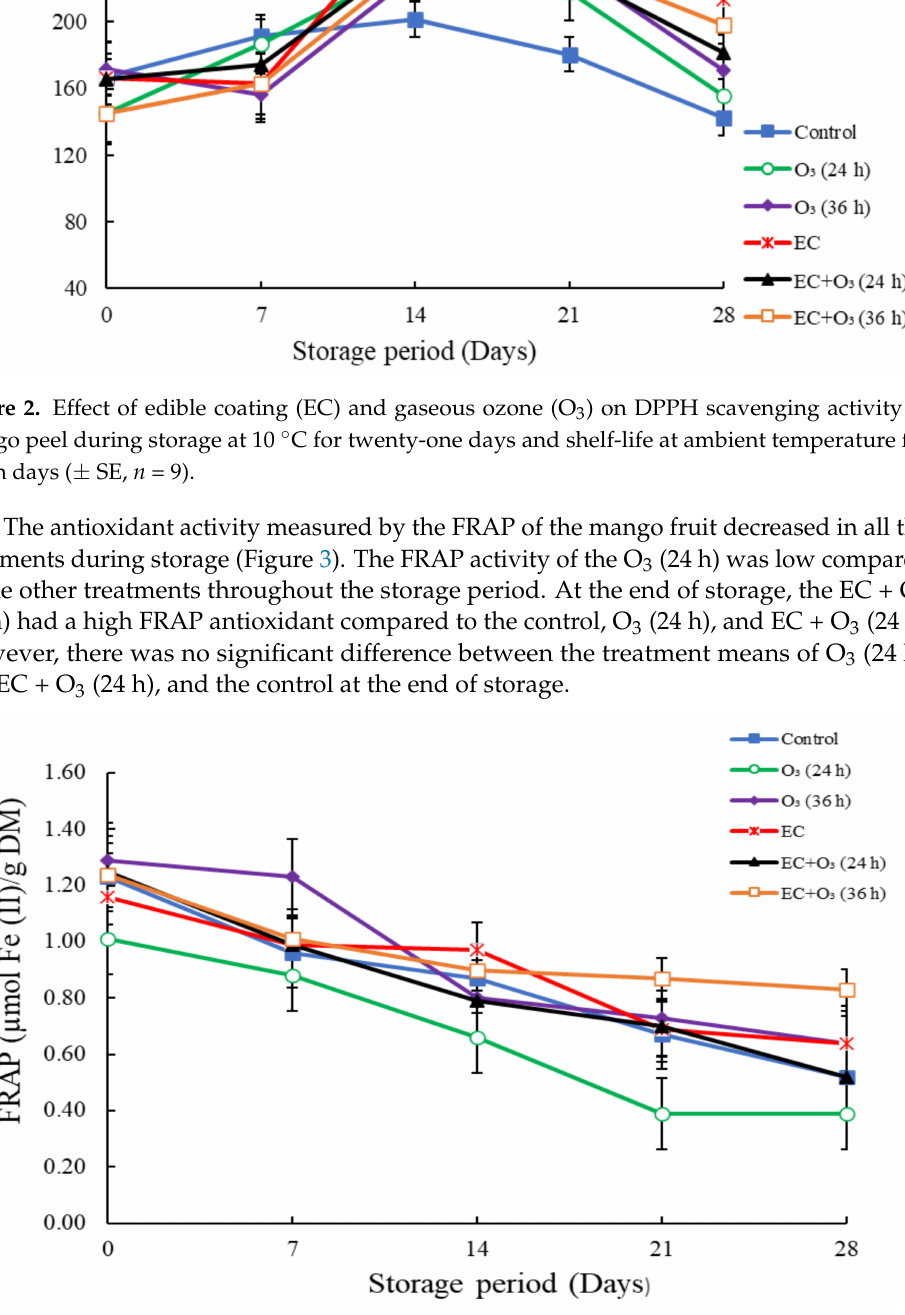
Figure 3. Effect of edible coating (EC) and gaseous ozone (O 3 ) on FRAP activity in mango peel during storage at 10 ◦ C for twenty-one days and shelf-life at ambient temperature for seven days ( ± SE, n =